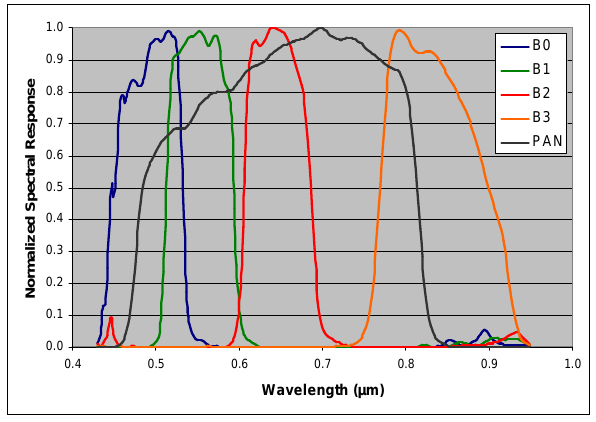
Figure 1. The PLEIADES.spectral